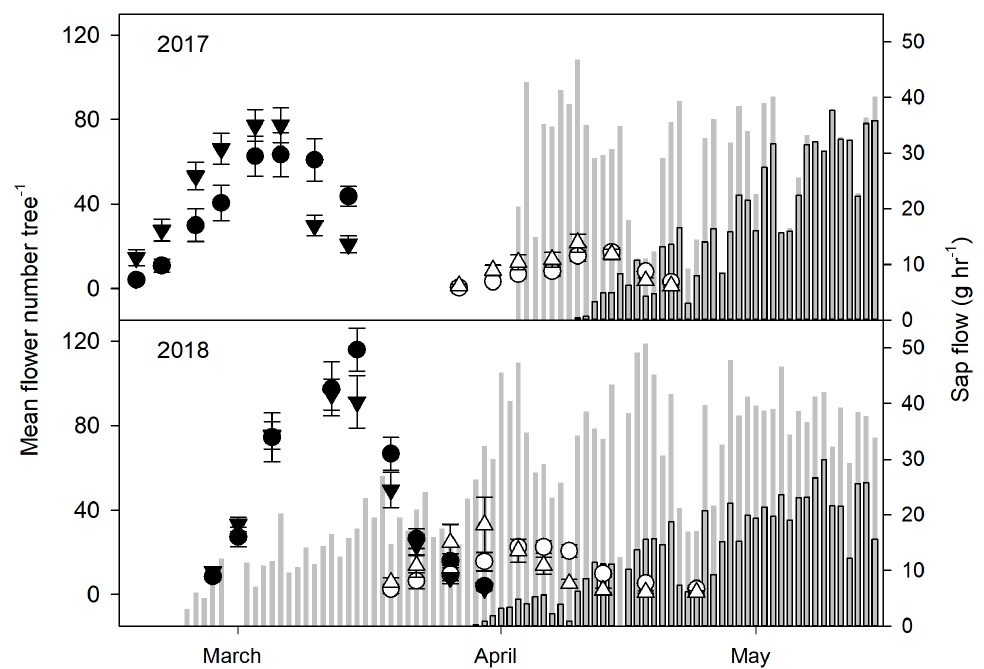
Figure 3. Mean number of spring flowers per tree at full bloom and sap flow in 2017 ( n = 16) and 2018 ( n = 8). The timing and amount of flowering of trees that had a normal senescence (filled symbols) was earlier and higher respectively compared to those that had a delayed senescence (open symbols), but similar between 100% ET (circles) and 50% ET (triangles) in respective senescence treatments. Sap flow began earlier for trees that had a normal senescence (grey bars) compared to those that had a delayed senescence (dark grey bars) in 2017 ( n = 6) and 2018 ( n = 5–6). Early spring sap flow data from the normal senescence trees is missing in 2017 since measurement readings began in April. Error bars represent ± standard error of the mean.